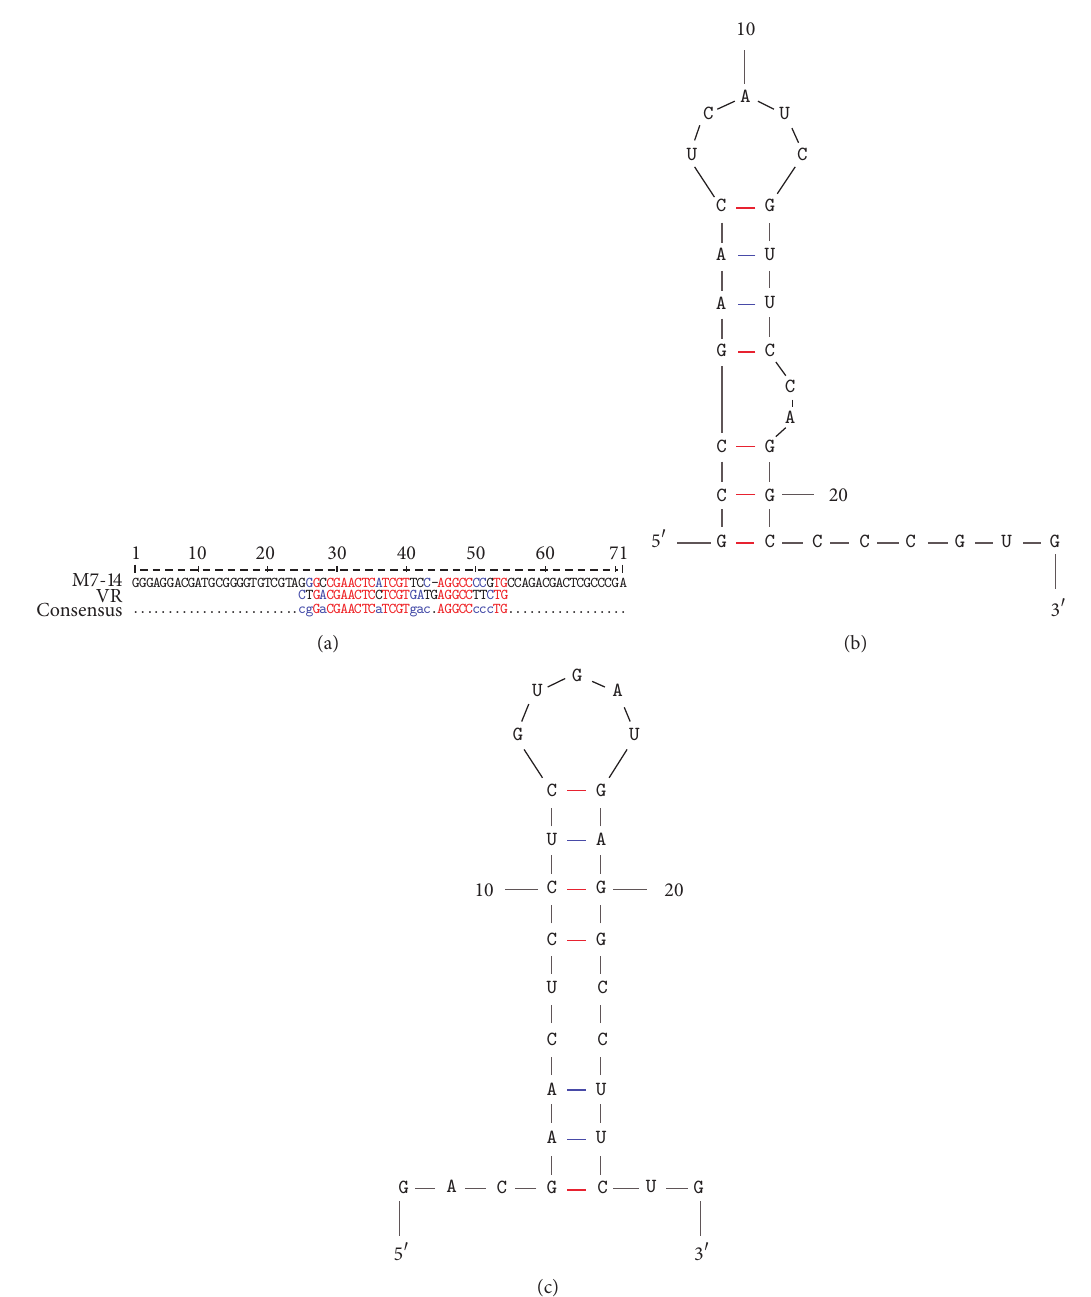
Figure 4: The sequence alignments of M7-14 and the variable region (VR) of the C3 aptamer [5]. The sequences were analyzed by using Multalign[9]program;64%ofthenucleotideswereidenticalbetweentheC3VRandtheM7-14VR.Thenucleotidesthatareidenticalbetween the two sequences are denoted in red font. The secondary structure of the aligned sequences for (b) M7-14 and (c) C3 VR, as predicted by the M-fold [7], identifies a common structural